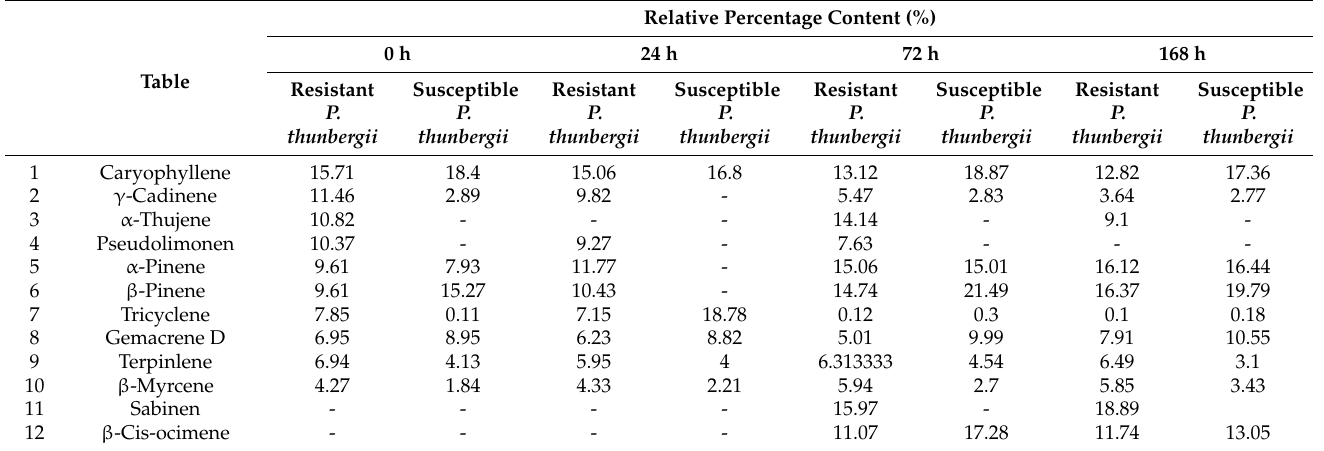
Table 2. Changes in the content of major terpenoids in P. thunbergii with different levels of resistance following inoculation with